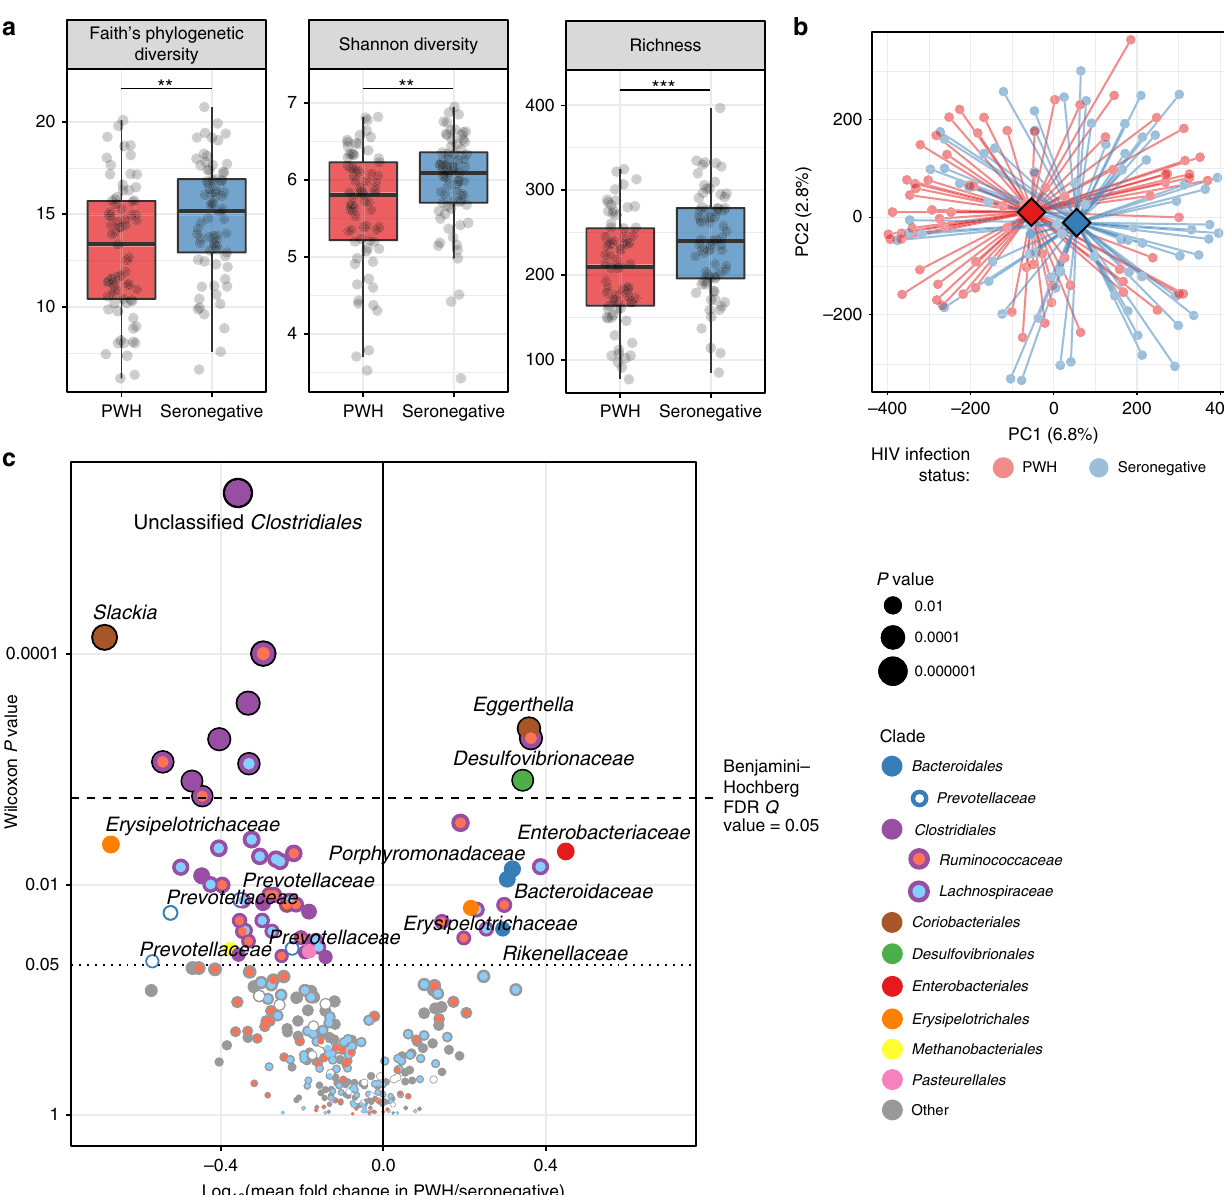
Fig. 1 Gut microbiota composition differs between PWH and uninfected controls. a Alpha diversity measures are shown for all participants, grouped as PWH and seronegative controls ( n = 142, two-tailed paired t -test P = 0.0012, P = 0.0012, P = 0.0004, respectively). Boxes denote inter-quartile range, bar denotes median, and whiskers denote range. b Principal coordinates analysis (PCoA) plot based on the Canberra beta diversity metric with centroids depicted as diamonds for PWH and seronegative controls. Community differences were veri fi ed by PERMANOVA, P = 0.001. c Volcano plot depicting ASVs (operational taxonomic units, referring to dada2 sequence variants) in differential abundance between PWH and seronegative controls using the paired non-parametric Wilcoxon signed-rank test, with pairs of PWH and controls matched for sex, sexual practice, age, BMI, and birth country. Benjamini – Hochberg false discovery rate Q -value cutoff of 0.05 is shown. ASVs are colored by either their family (for Lachnospiraceae , Ruminococcaceae , and Prevotellacaeae ) or order (all else), and families of selected taxa are denoted by text. * P < 0.05, ** P < 0.005, *** P <